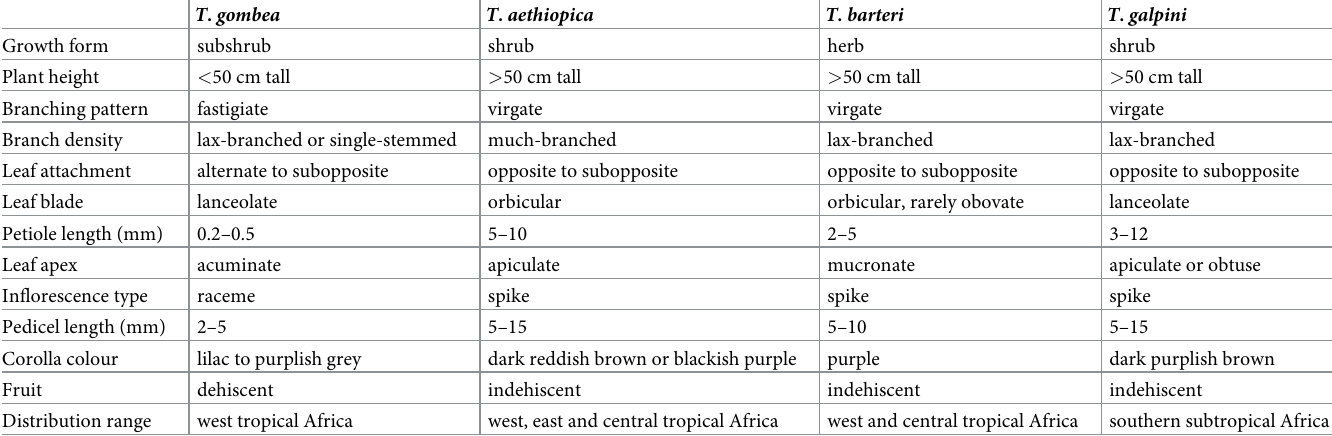
Table 3. Morphological comparisons of T . gombea to congener species, T . aethiopica , T . barteri and T . galpini